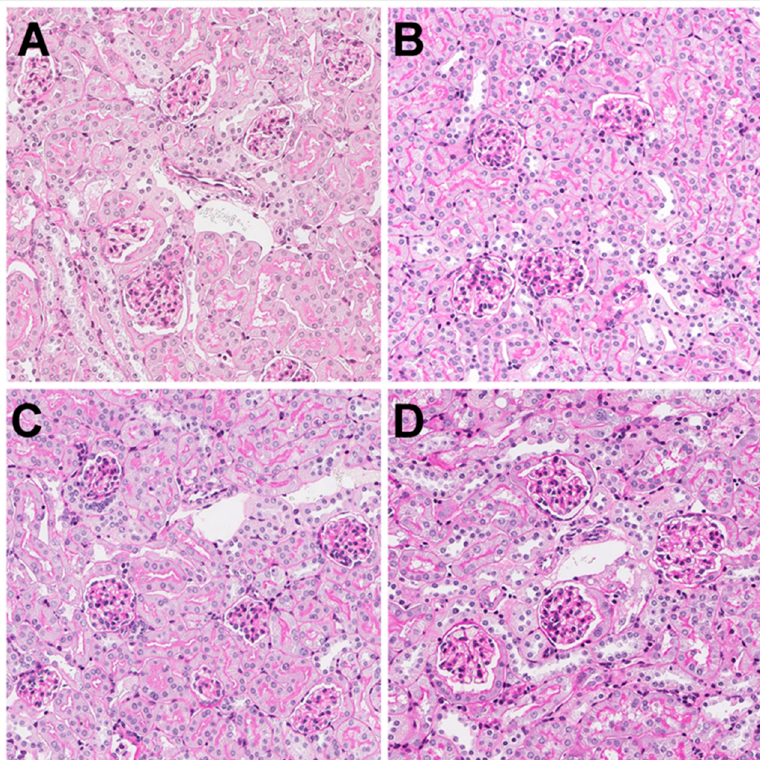
Figure 6. Light microscopy image of a kidney histology sample using Periodic acid-Schiff staining. ( A ) doxorubicin; ( B ) doxorubicin and ultrasound; ( C ) doxorubicin, ultrasound, and Sonazoid™; and ( D ) doxorubicin, ultrasound, and SonoVue ® . All four groups had normal-looking renal structures. Picture size: 400 µm × 400 µm at 20× magnification.